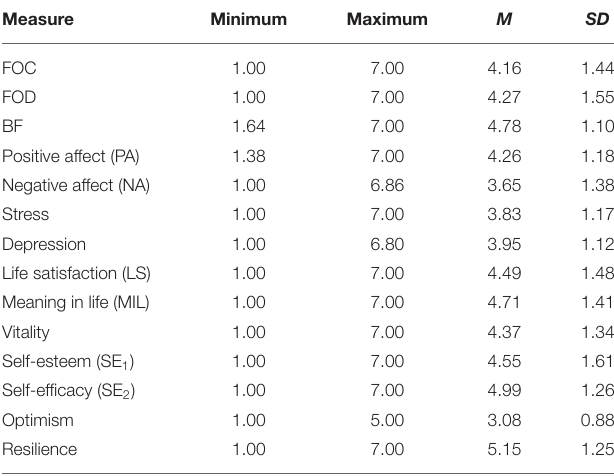
TABLE 1 | Descriptive statistics for all scales ( N =